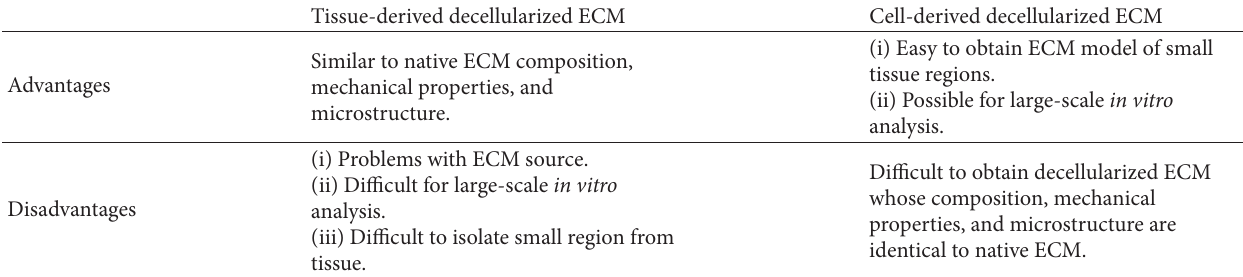
Table 3: Summary of the differences between tissue-derived and cell-derived decellularized